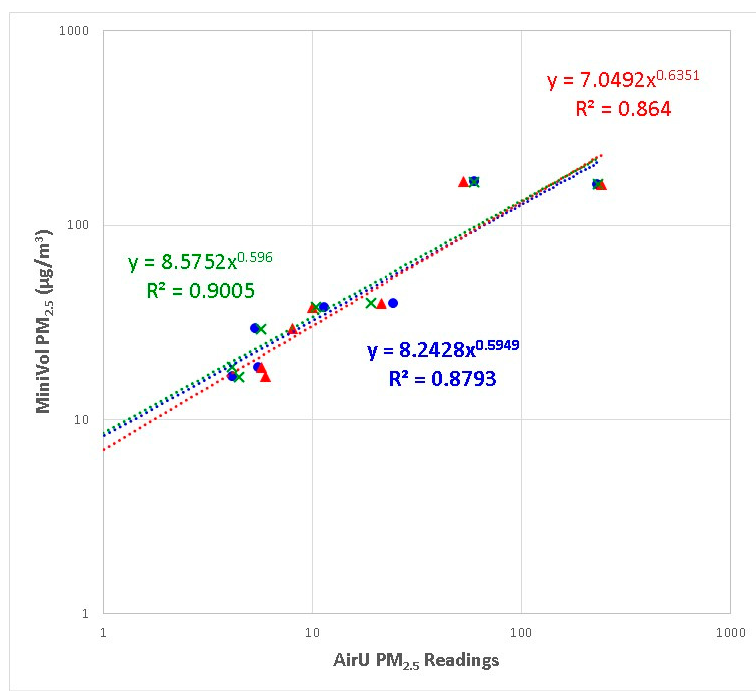
Figure 4. Calibration results of the locally calibrated particulate monitors (AirUs) against the Mini-Vol. The different colors (and markers) represent different AirUs. The lowest MiniVol concentration was measured at the indoor (WESI) site, the middle 5 were measured at ambient sites, and the highest concentration was measured at a smoke shop (indoor site).